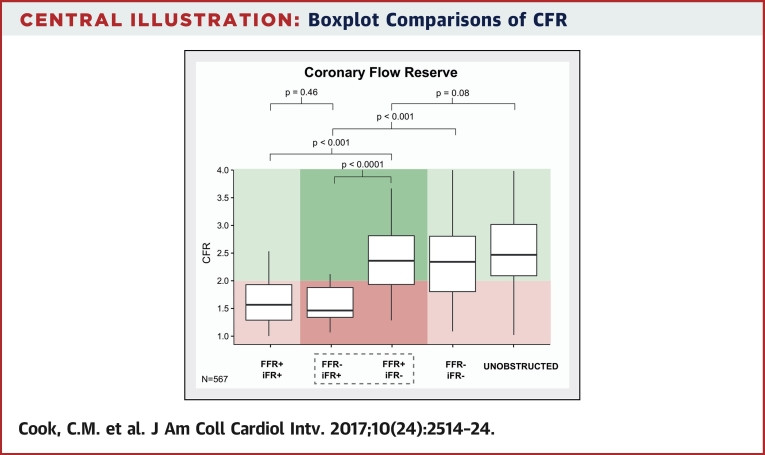
Boxplot Comparisons of CFRThe horizontal black line indicates the median value. The box indicates the interquartile range, and the whiskers indicate the range of values. Coronary flow reserve (CFR) values ≤2 and >2 are colored pink and green, respectively. CFR was significantly higher in the fractional flow reserve (FFR) positive and instantaneous wave-free ratio (iFR) negative versus FFR–/iFR+ discordant groups (and similar to FFR–/iFR– and unobstructed reference vessel groups).